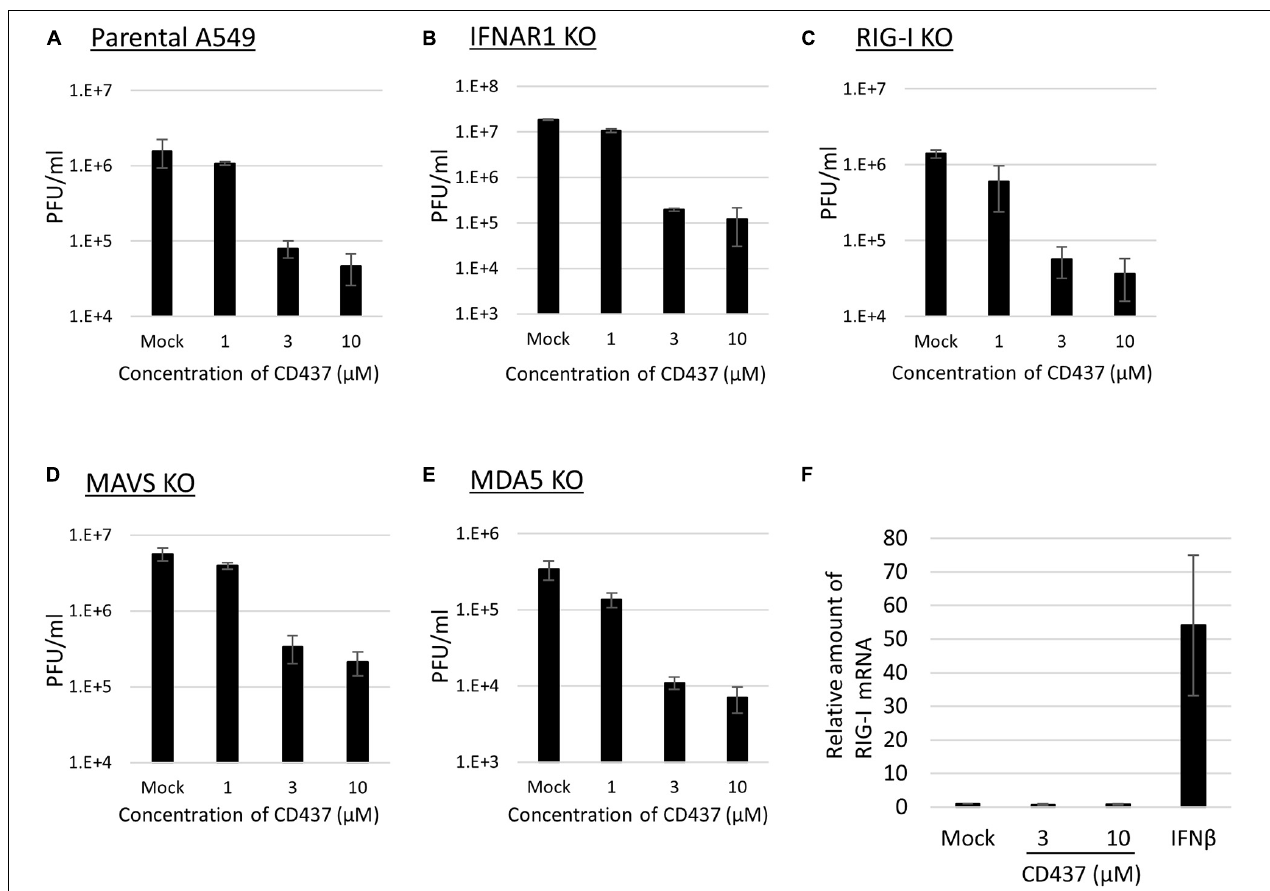
FIGURE 4 | CD437 also inhibited MuV replication in RIG-I knockout cells. MuV was inhibited by CD437 in panel (A) parental A549/hSLAM cells, (B) IFNAR1-KO A549/hSLAM cells, (C) RIG-I-KO A549/hSLAM cells, (D) MAVS-KO-A549/hSLAM cells, and (E) MDA5-KO-A549/hSLAM cells. A total of 0–10 µ M of CD437 was co-cultured with the MuV Odate strain at an MOI of 0.01. At 72 h post-infection, the supernatant was collected and the infectious titer was measured by plaque assay. The EC 50 was calculated using the Reed and Muench method. (F) Quantification of retinoic acid-inducible gene (RIG-I) mRNA using IFN β as a control. A total of 0–10 µ M of CD437 and 1,000 Units/ml of IFN α A/D were treated with A549/SLAM for 24 h. mRNA was measured by